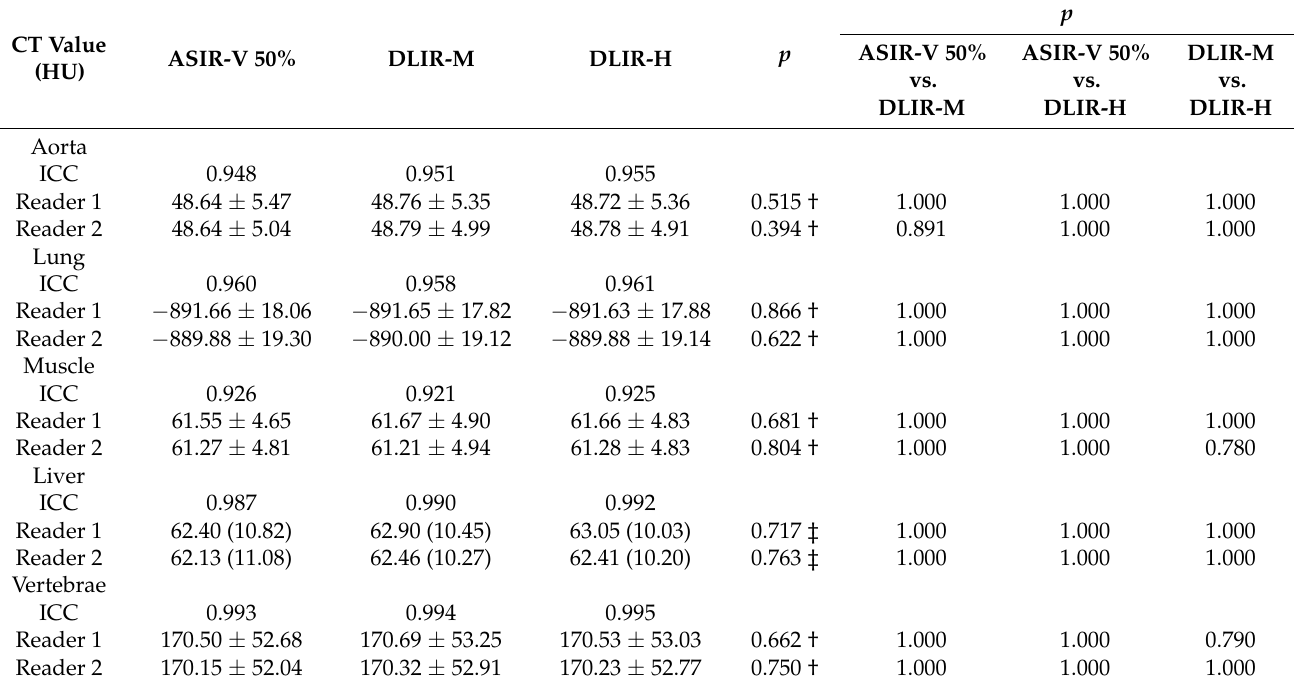
Table 1. Comparison of image CT values among the three